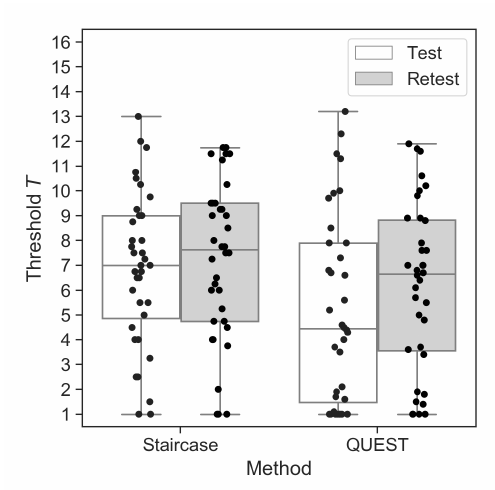
Figure 1. Threshold estimates for the staircase and QUEST procedures during Test and Retest sessions. Each dot represents one participant. Horizontal lines show the median values, and whisker lengths represent 1.5 × inter-quartile